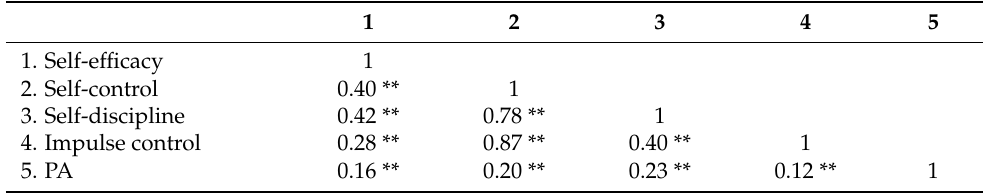
Table 3. Correlation